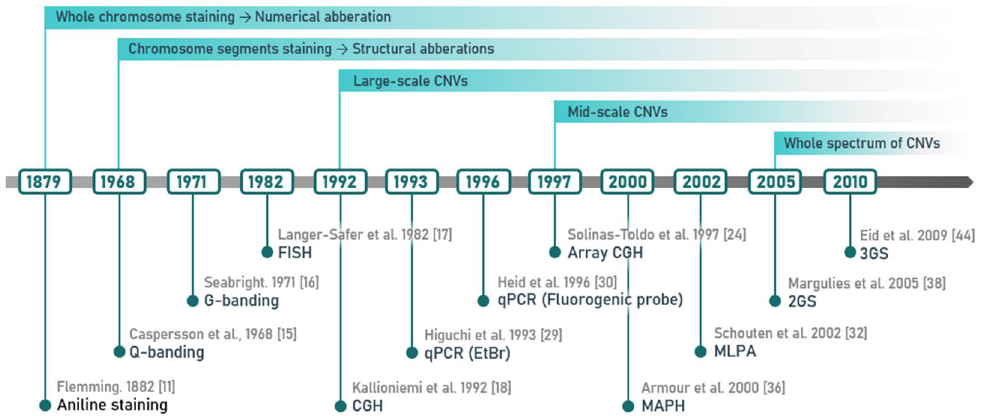
Figure 1. Hallmarks in copy number variant (CNV) history. The 20th century saw a steady development of methods, which finally allowed genome-wide, high-resolution CNV detection around the beginning of the 21st century.